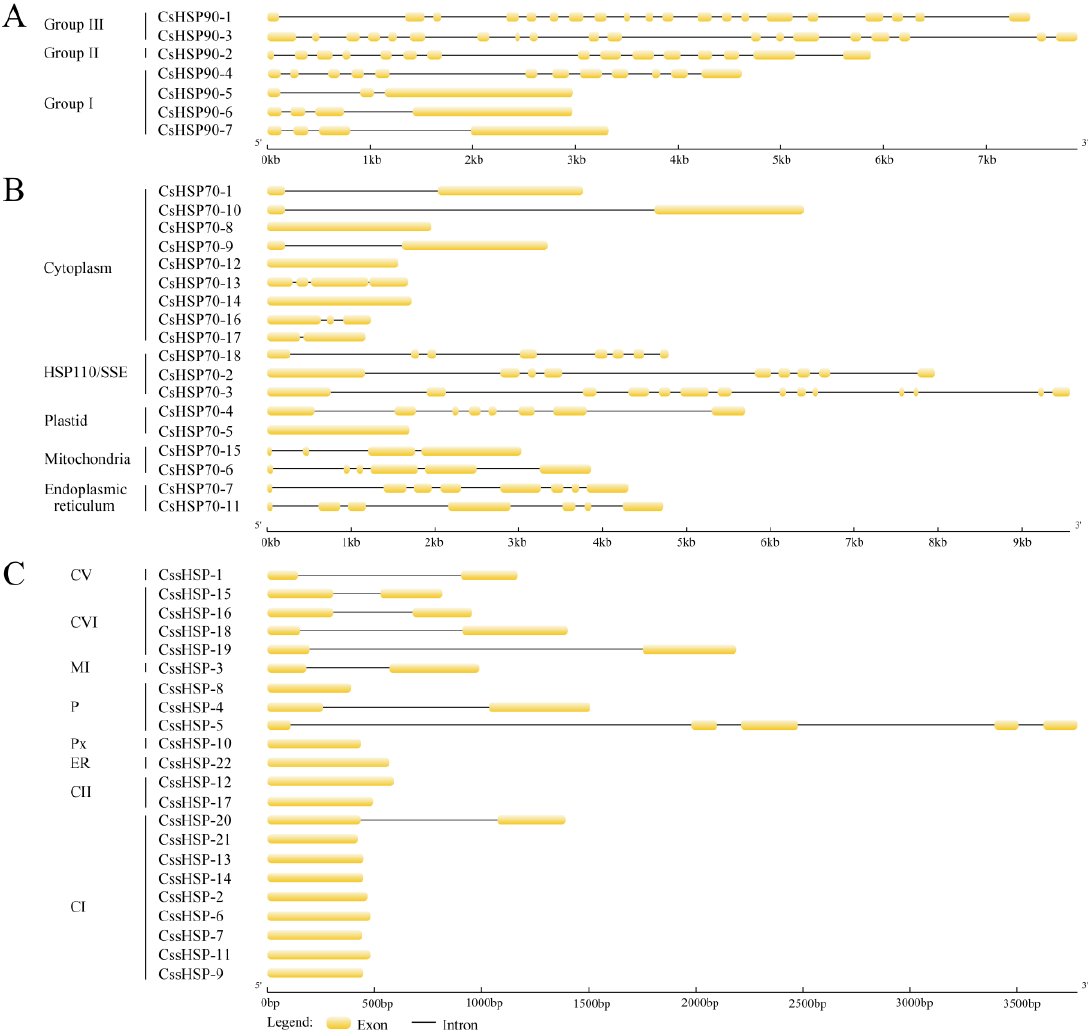
Figure 3. Exon–intron structure analyses of CsHSP90 ( A ), CsHSP70 ( B ), and CssHSP ( C ) genes. The yellow sections represent exons, and the grey parts indicate introns. CI, CII, CV, and CVI: cytoplasm I, II, V and VI; ER: endoplasmic reticulum, MI: mitochondria I; P: plastid; and Px: peroxide.